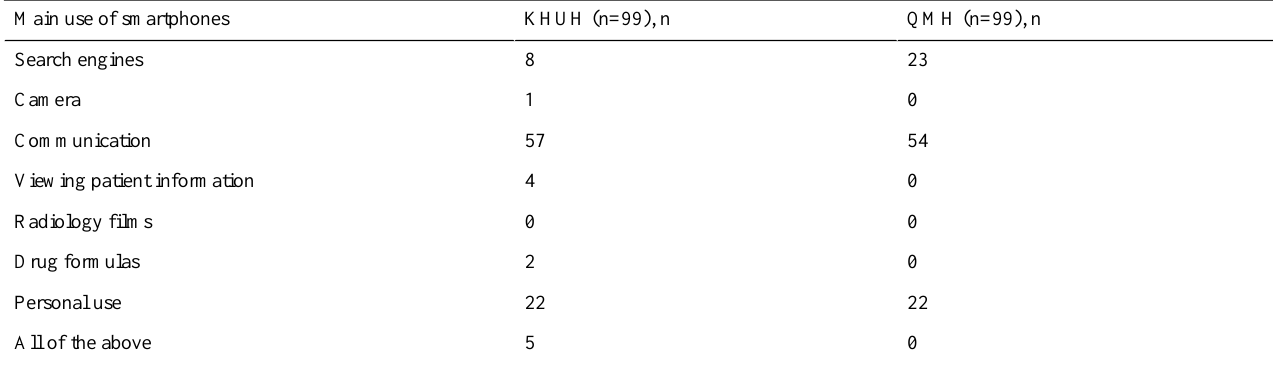
Table 2. Smartphone use by doctors in King Hamad University Hospital (KHUH) and Queen Mary Hospital